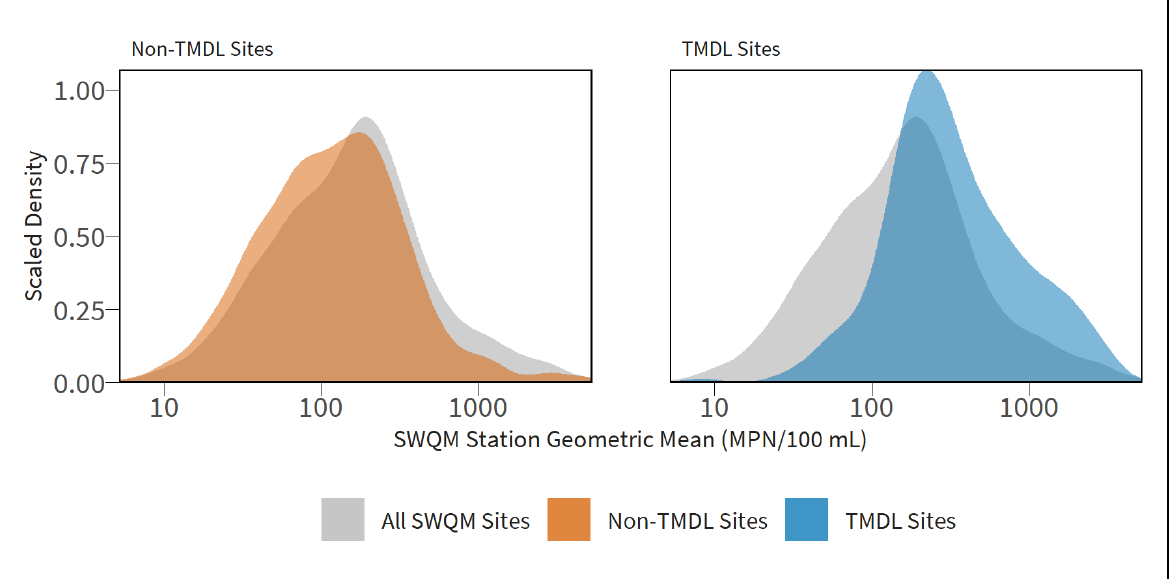
Figure 3. Scaled density plots of E. coli geometric mean distribution for TMDL and non-TMDL SWQM sites across